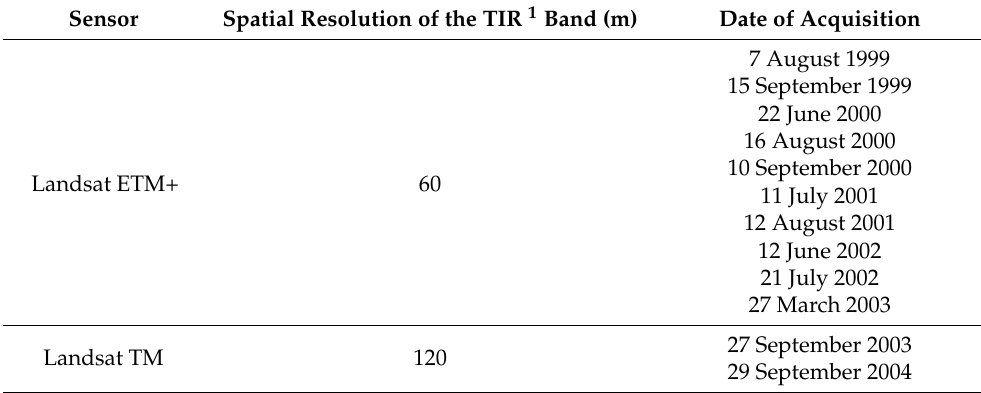
Table 2. Landsat images considered in this study. Sensor Spatial Resolution of the TIR 1 Band